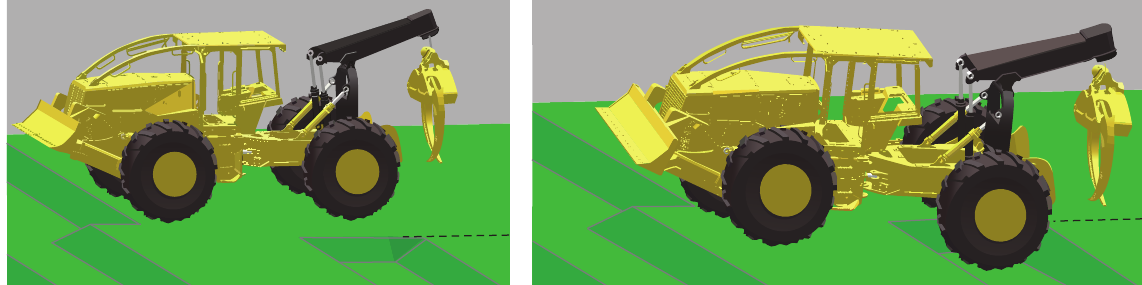
Figure 13: Static equilibrium of wheeled machine (grapple skidder) on a washboard